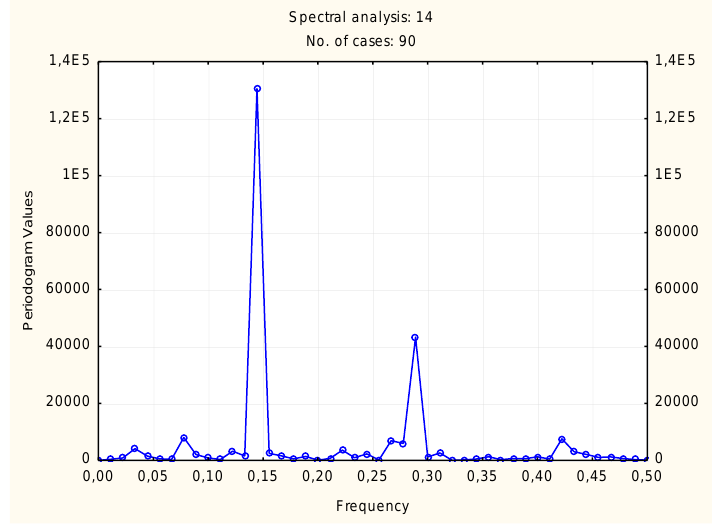
Fig. 8. Periodogram of passenger flows of bus route №85.